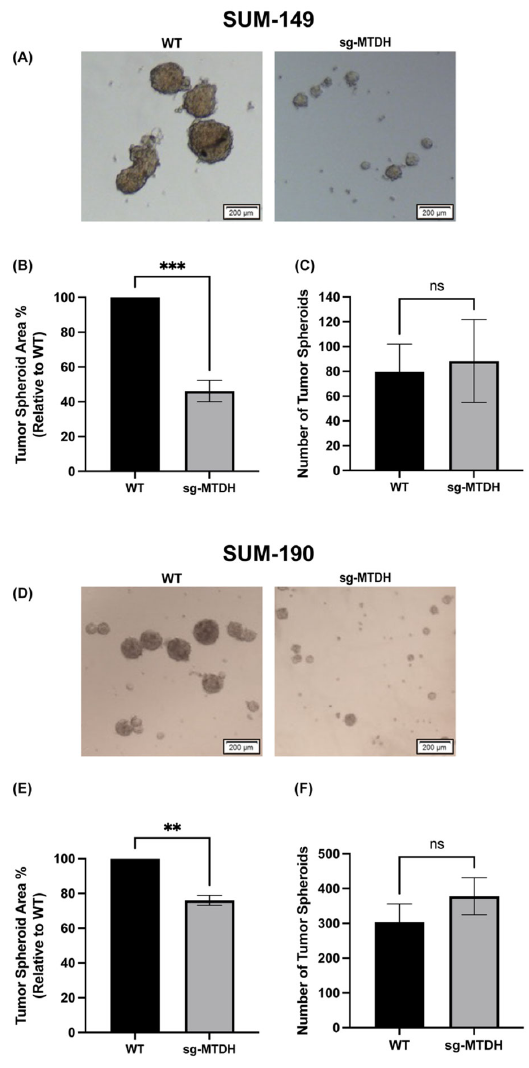
Figure 3. IBC ‐ derived tumor spheroids size was significantly reduced in MDTH silenced IBC cells. SUM ‐ 149 and SUM ‐ 190, WT and sg ‐ MTDH cells, were grown in ultralow attachment plates for 96 h to allow IBC ‐ derived tumor spheroids to form. ( A ) Micrographs of SUM ‐ 149 WT and sg ‐ MTDH represent a region of an image montage of each condition. ( B ) Area and ( C ) number of SUM ‐ 149 WT and sg ‐ MTDH tumor spheroids. ( D ) Micrographs of SUM ‐ 190 WT and sg ‐ MTDH represent a region of an image montage of each condition. ( E ) Area and ( F ) number of SUM ‐ 190 WT and sg ‐ MTDH tumor spheroids. The area and number of tumor spheroids were quantified using Gen5 Data Anal ‐ ysis Software. Scale bar = 200 μ m. Student’s t ‐ test ** p < 0.01, *** p < 0.001, ns: not significant. Results are shown as Mean ± SEM. The experiment was carried out at least three